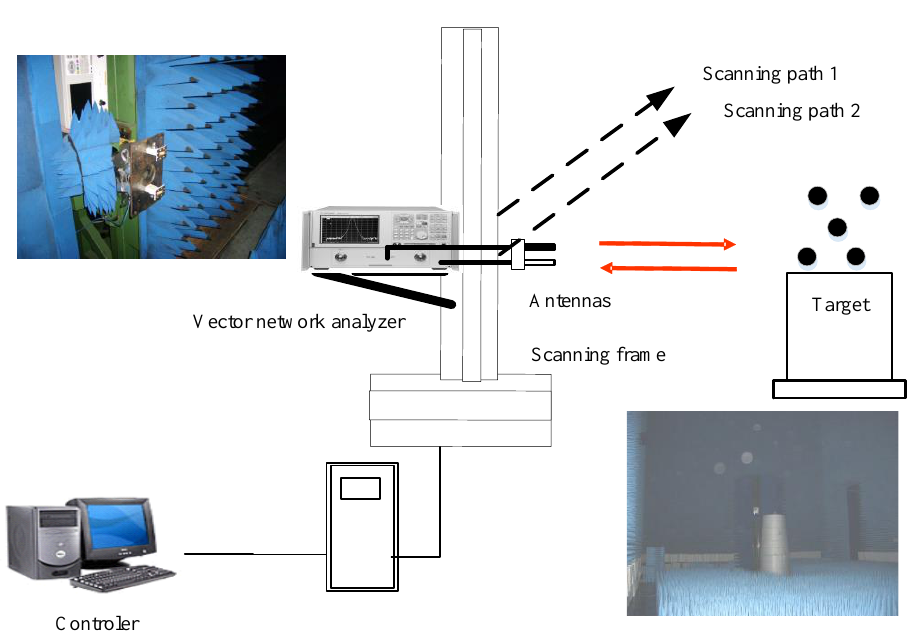
Figure 4. InSAR hardware-in-the-loop system constructed in the anechoic chamber.